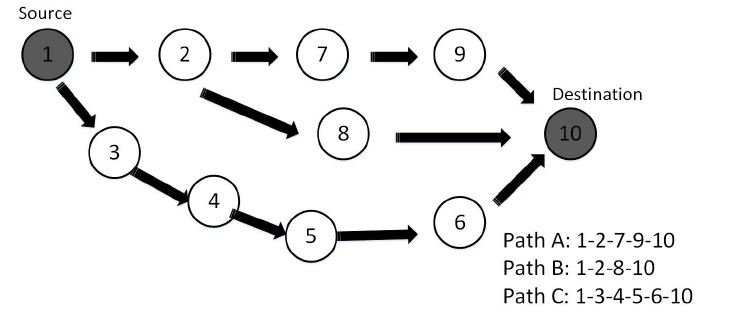
Figure 2. Topology of Communication in IoT: A glimpse of a normal communication taking place in the network different path from source to destination is selected for communication.